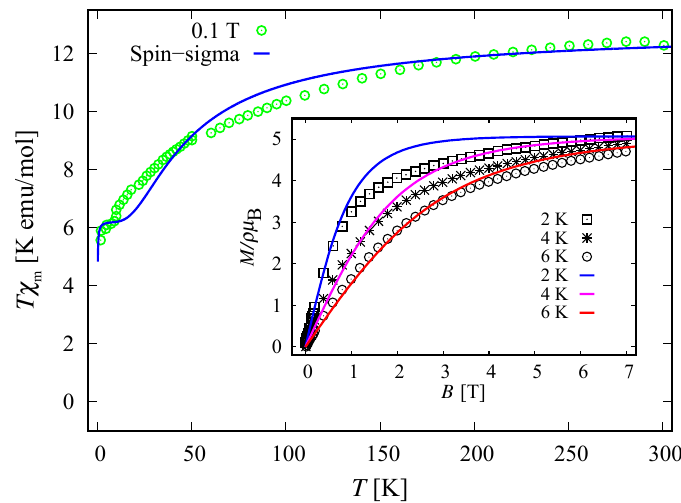
Figure 10. Experimental data from Reference [24] and calculated molar susceptibility of the bis(phthalocyaninato) Er 3 + complex [(Pc)Er{Pc{N(C 4 H 9 ) 2 } 8 }] · as a function of temperature, multi- plied by the temperature, for B = 0.1 T and b = 0 T. The inset shows the dc field dependence of the corresponding non-dimensional magnetization in the case of three different temperatures, where ρ and µ B are the number of isolated complexes per unit volume and Bohr magneton, respectively. In both figures, the solid lines represent the theoretical results obtained with respect to the spin–sigma Hamiltonian (1).